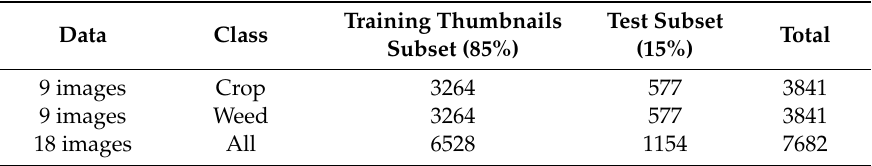
Table 3. Training and validation dataset in the wheat field.